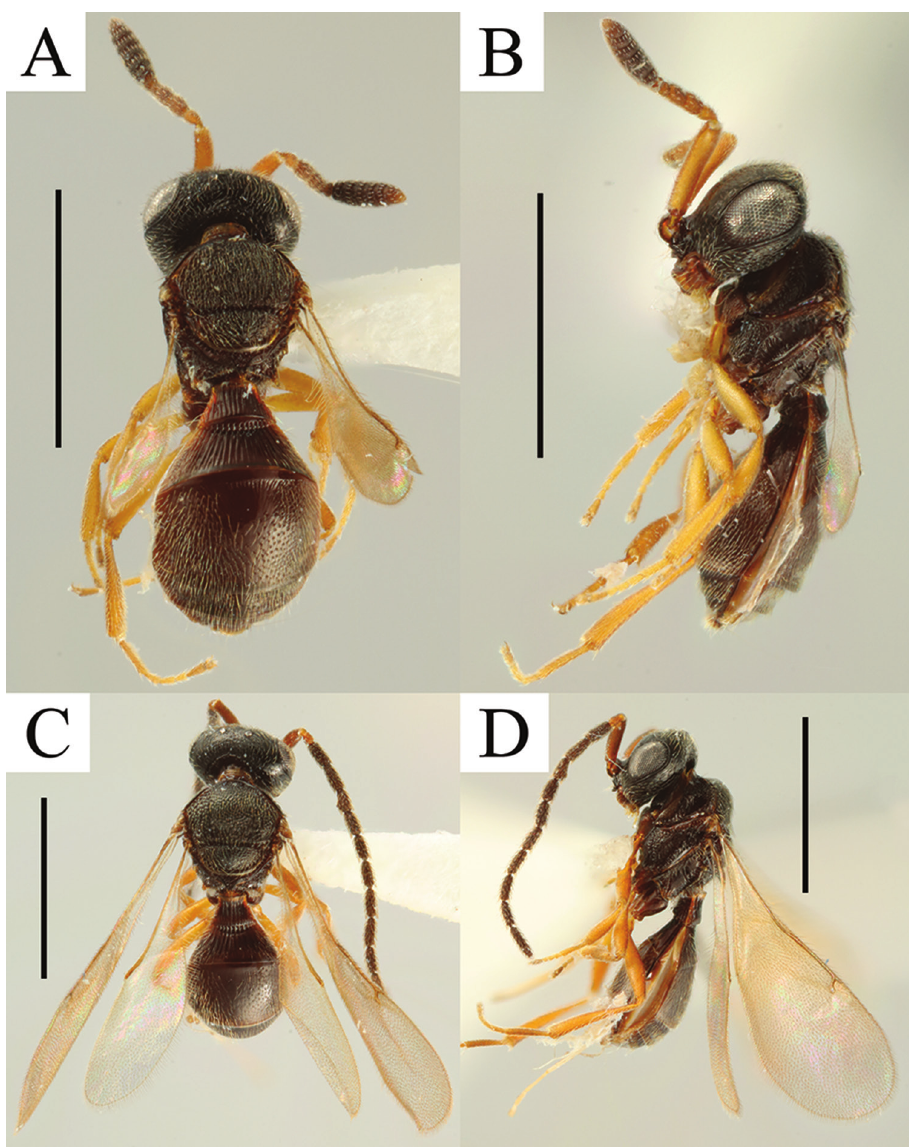
Figure 3. Trimorus haniyasu sp. n. A female, dorsal view B female lateral view C male, dorsal view D male lateral view. Scale bars: 1